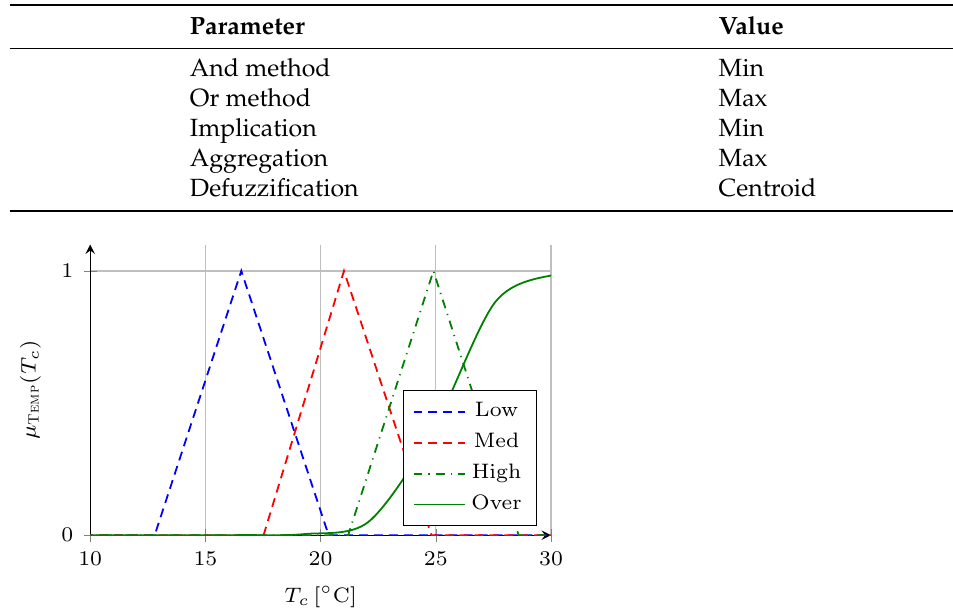
Table 1. Parameters of the FIS.